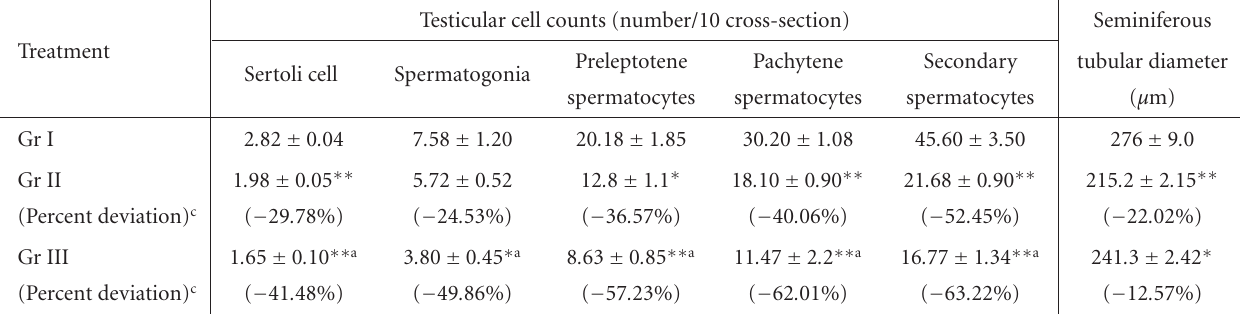
Table 4: Testicular cell population dynamics following the treatment of compounds 1 and 2 (values are mean ± SEM ( n = 6)).